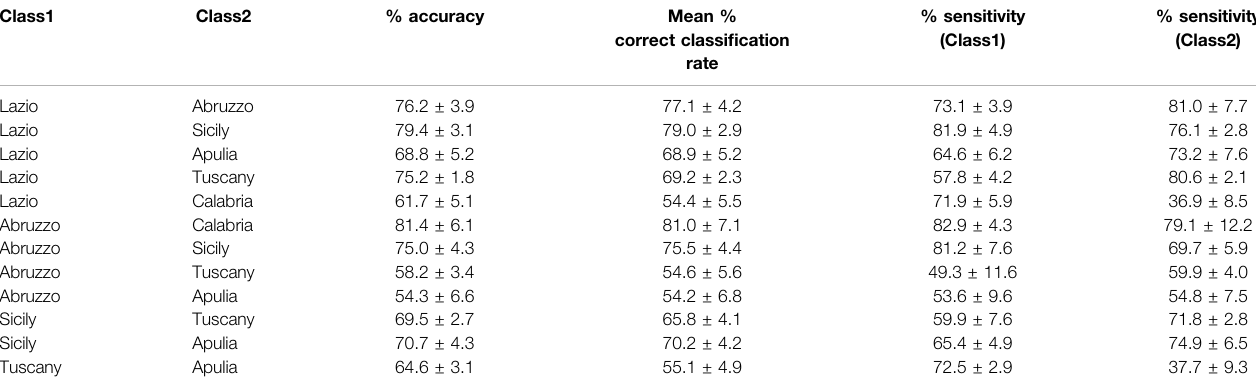
TABLE 5 | PLS-DA discrimination between pairs of geographical origin. Figures of merit estimated on the outer loop of the rDCV procedure (expressed as mean ± standard deviation).